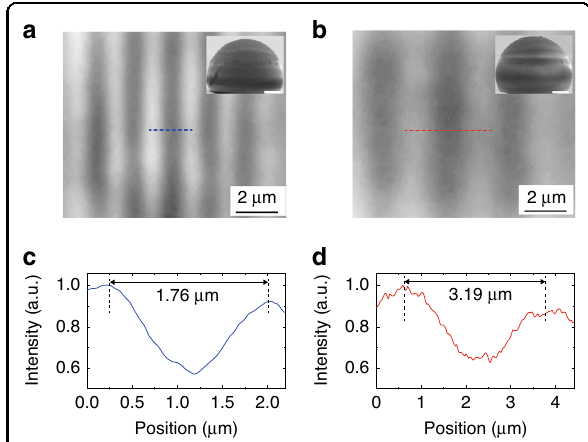
Fig. 4 Customizable magni fi cation of HHMSs. Images of a blu-ray disc captured by n ~ 2.34 HHMSs with ( a ) d = 23.2 μ m, t = 16.5 μ m and ( b ) d = 23.7 μ m, t = 17.9 μ m. The insets display the side-view SEM images of the two HHMSs. Scale bar in insets: 5 μ m. c , d Intensity pro fi les along blue and red dashed lines in ( a ) and ( b ),